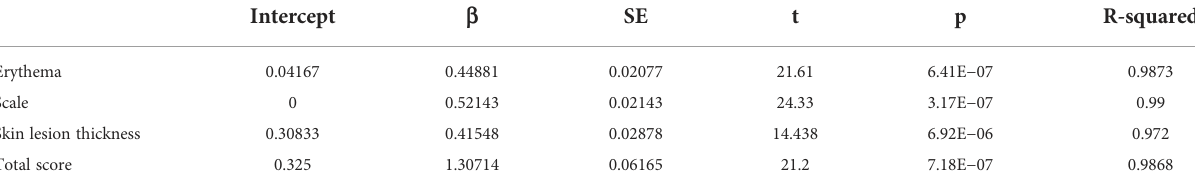
TABLE 2 Results of correlation analysis between PASI score and time in model group B.